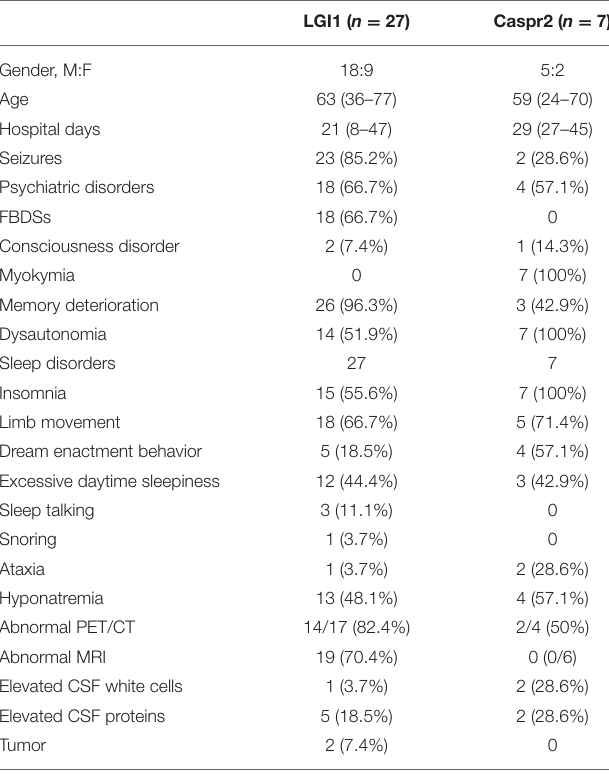
TABLE 2 | PSG results of patients with LGI1-Ab encephalitis and healthy controls. TABLE 1 | The clinical manifestations of patients with LGI1-antibody encephalitis and Caspr2-antibody-associated diseases. LGI1 LGI1 ( n = 27) Caspr2 ( n = 7)